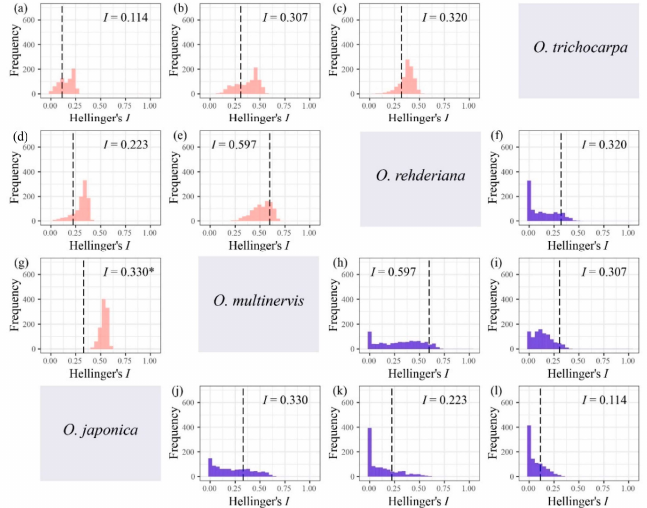
Figure A3. Niche overlap tests for four Ostrya species based on Hellinger’s I , i.e., O. japonica vs. O. trichocarpa ( a ), O. multinervis vs. O. trichocarpa ( b ), O. rehderiana vs. O. trichocarpa ( c ), O. japonica vs. O. rehderiana ( d ), O. multinervis vs. O. rehderiana ( e ), and O. japonica vs. O. multinervis ( g ) using niche equivalency test; O. rehderiana vs. O. trichocarpa ( f ), O. multinervis vs. O. rehderiana ( h ), O. multinervis vs. O. trichocarpa ( i ), O. japonica vs. O. multinervis ( j ), O. japonica vs. O. rehderiana ( k ), and O. japonica vs. O. trichocarpa ( l ) using similarity test. Pink and blue represent equivalency and similarity tests respectively. The Matric I assumed the niche overlap in distribution probability (Warren et al., 2008), ranging from 0 (no overlap) to 1 (complete overlap). The black dotted line represents the observed niche overlap between species pair (i.e., the empirical values of I ), whereas the histograms are those expected under the null hypotheses, and * represents the niches are significantly ( p < 0.05) more different than expected by